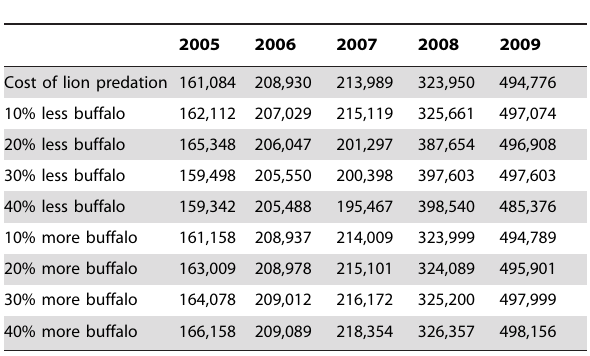
Table 2. The relative financial costs (in US dollars) of lions when changing the relative predation rates on buffalo by as much as 40% (sensitivity